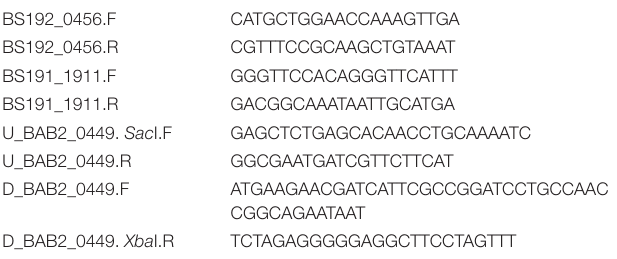
TABLE 2 | Oligonucleotides used in this